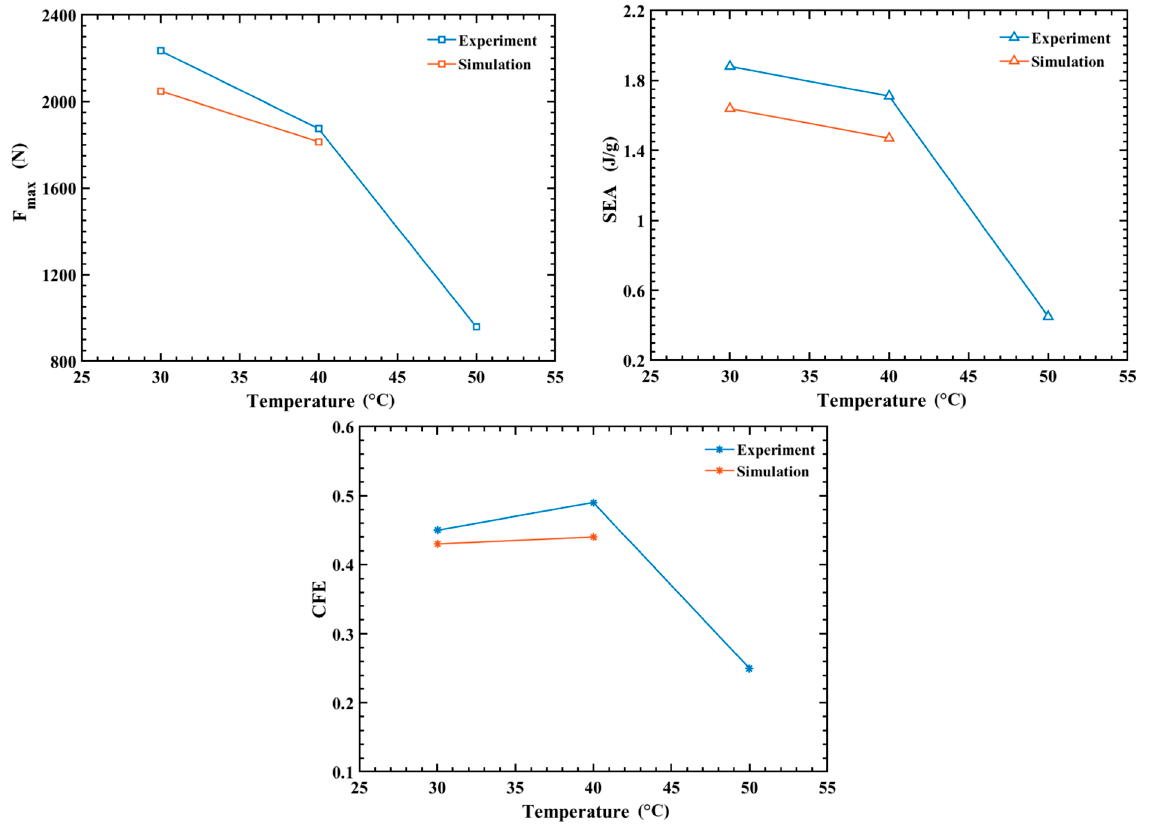
Figure 11. Experimental and simulated energy absorption indexes at different temperatures.